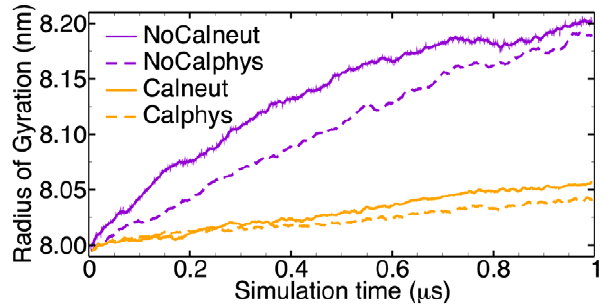
Figure 2. Radius of gyration. The R G of the C a atoms of the shell domain (residues 25–195) plotted every 1 ns with a running average over 10 points (non-averaged data also shown for Sim NoCa D neut ).